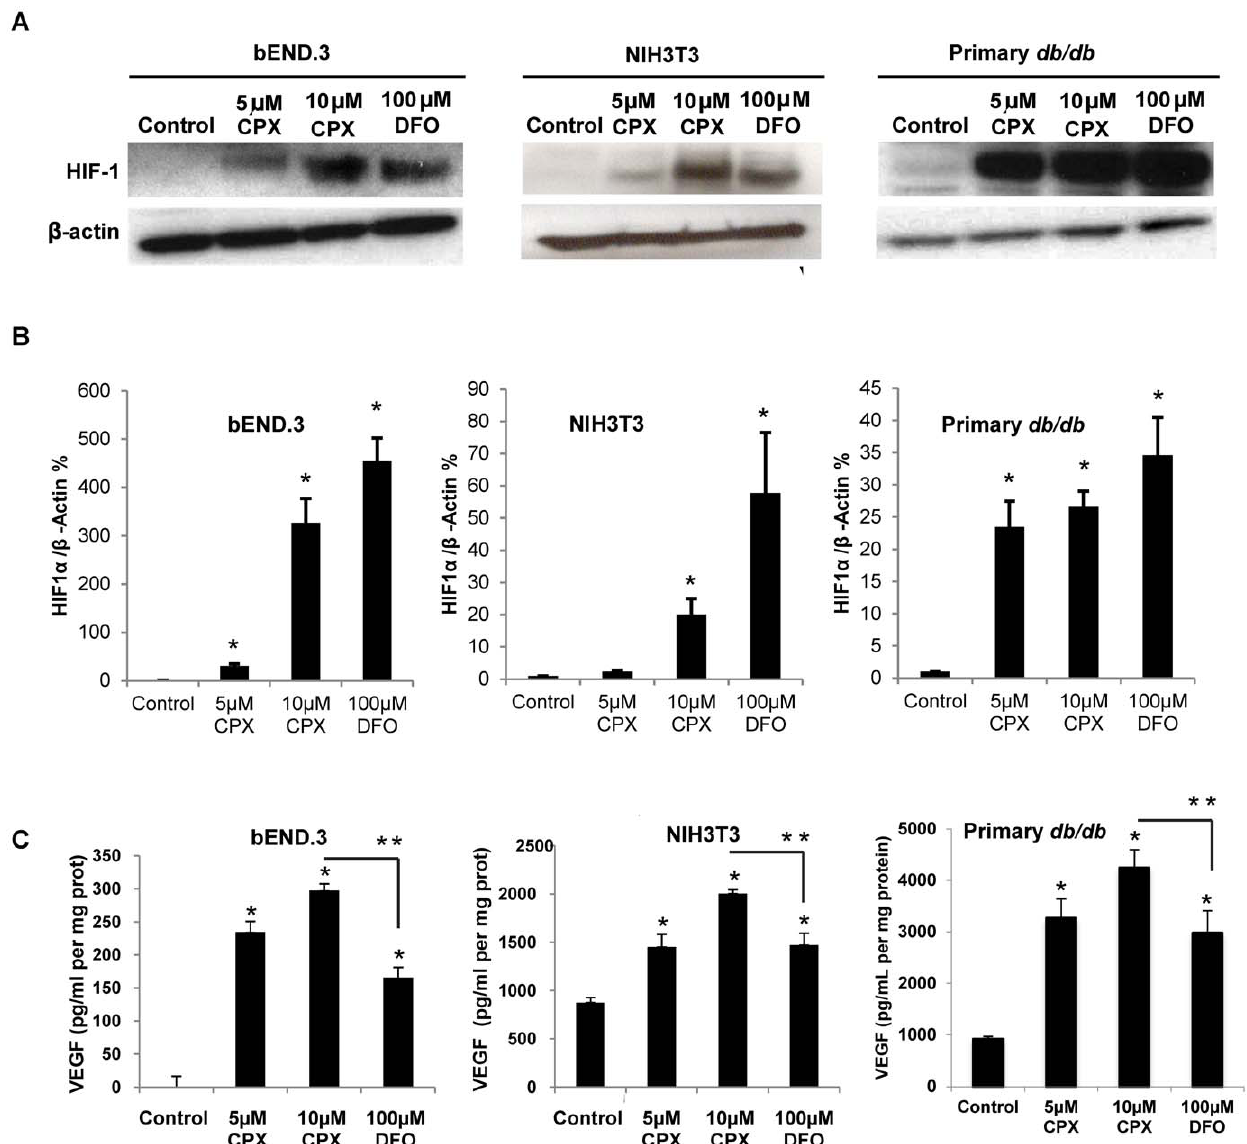
Figure 1 . Effect of CPX treatment invitro . ( A ) Treatment with 5–10 m M CPX for 24 hours on bEND.3 endothelial cell line, NIH3T3 cell line, and primary diabetic fibroblasts stimulated HIF-1 a activation in a dose-dependent manner ( B ) Densiometry data showing pixel density of Western blot data calculated using ImageJ software. Pixel density is expressed as a ratio to b -actin and normalized to untreated cells. Astericks indicate statistically significant increase in protein concentration relative to untreated controls. (*p , 0.05) ( C ) Conditioned media of cells treated with 5–10 m M CPX for 24 hours led to a significant increase in VEGF expression as detected by ELISA in bEND.3, NIH3T3, and diabetic primary fibroblast cells. (*p , 0.05).